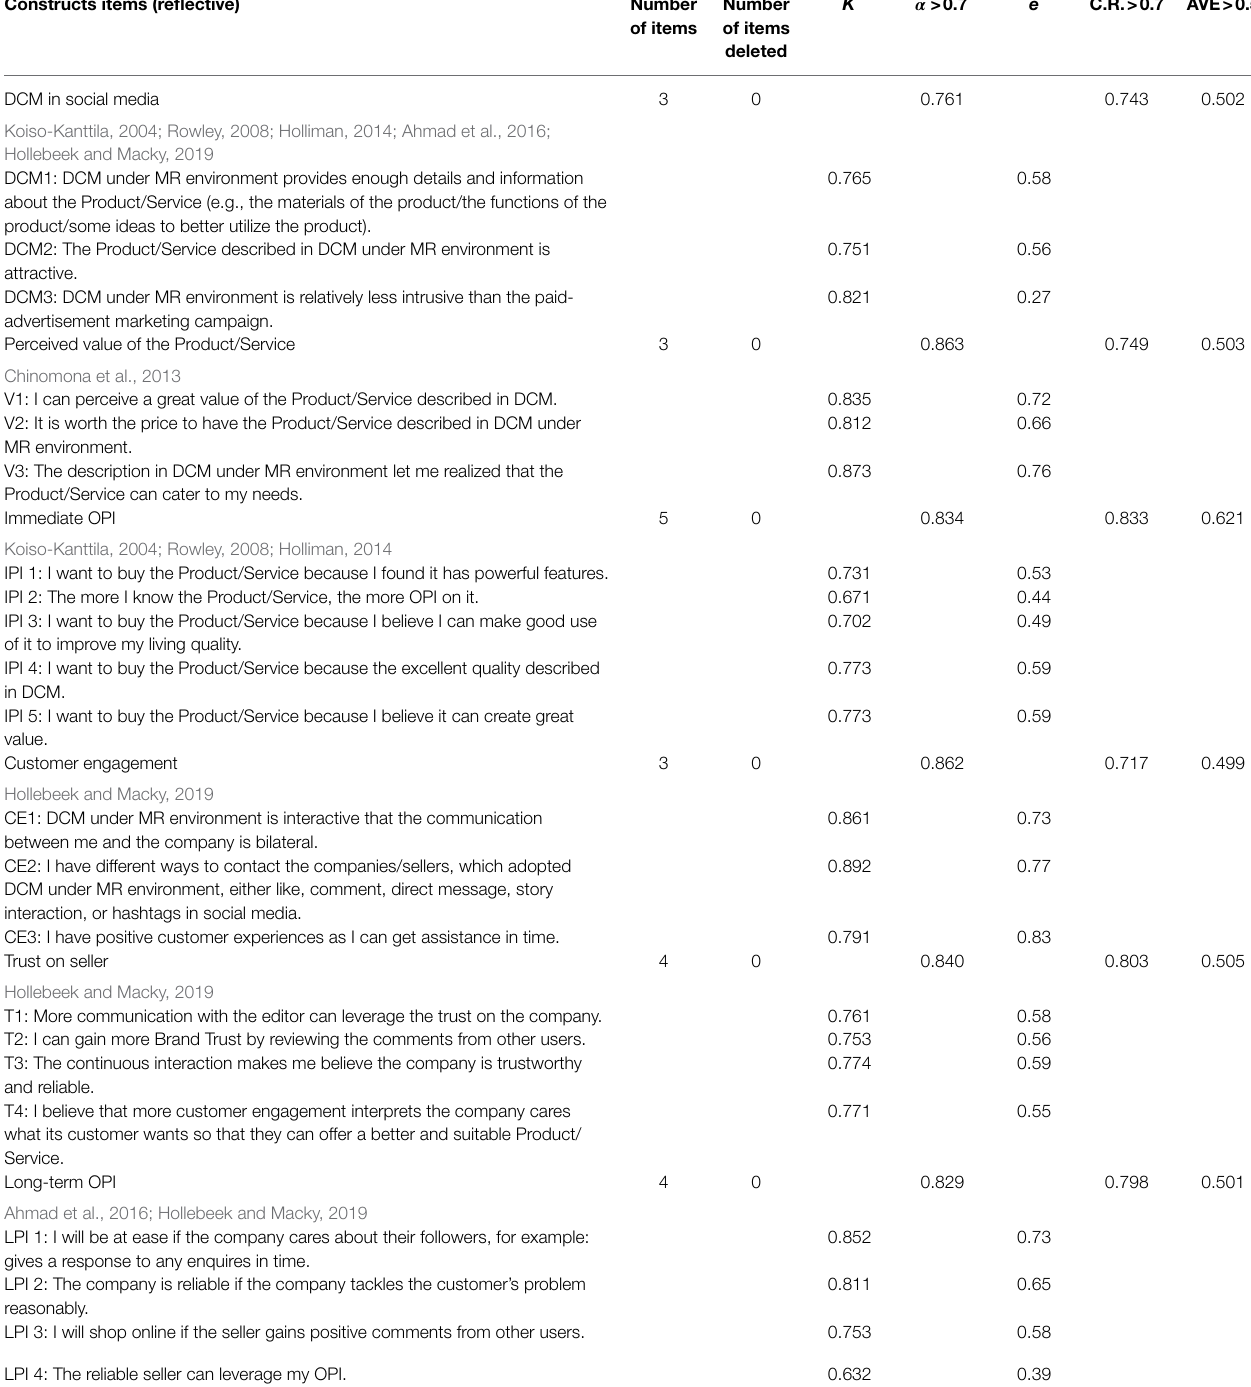
TABLE 2 | The measurement model (convergent